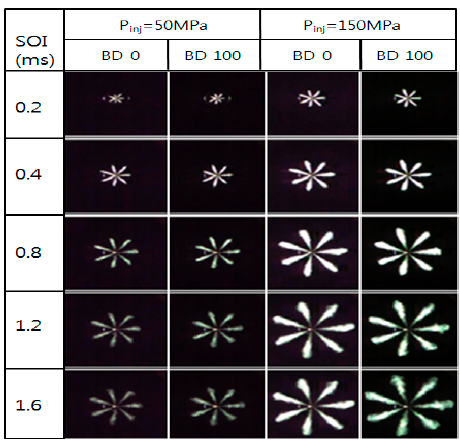
Figure 10. The spray pattern of diesel and canola oil biodiesel at different injection pressures (adapted with permission from [59], Elsevier, 2017). SOI: start of injection.